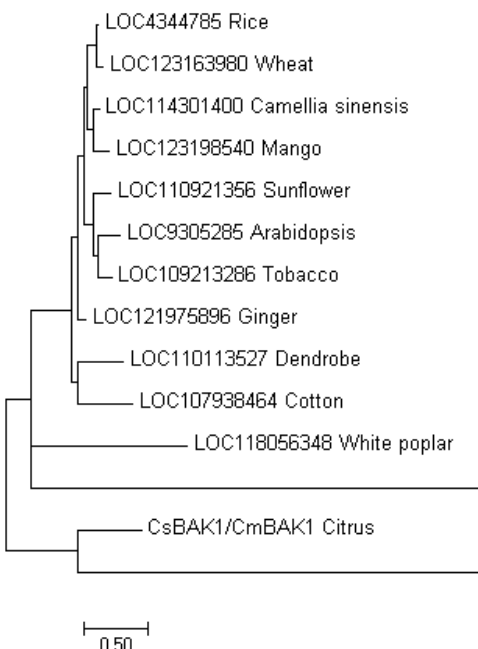
Figure 4. Phylogenetic analysis of BAK1 in different citrus species.